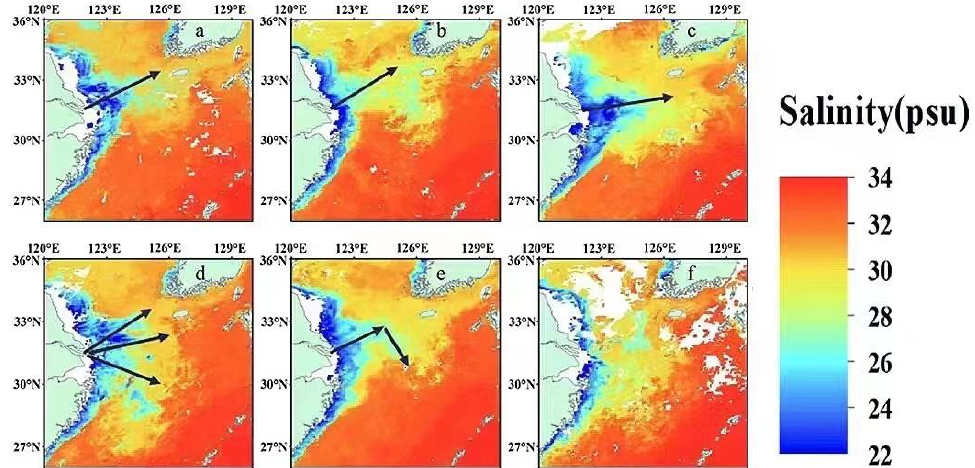
Figure 11. The expansion type of the Yangtze River ’ s diluent water (( a ) is the northeast expansion type in 2005, ( b , e ) are the northeast expansion type in 2004 and 2017, ( c ) is the northeast expansion type in 2020, ( d , f ) are the multidirectional expansion type in 2014 and 2015 type).